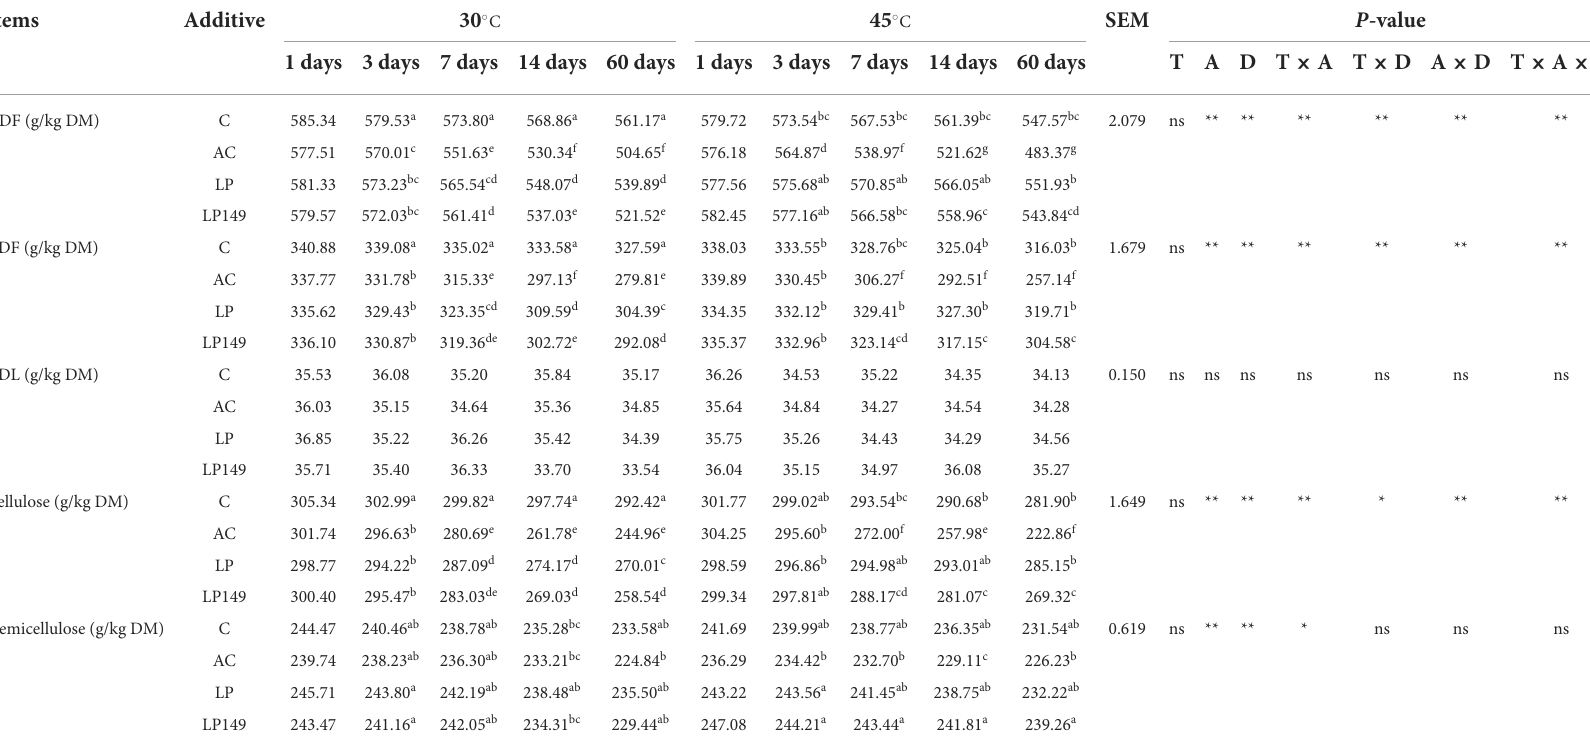
TABLE 2 Lignocellulose compositions of hybrid elephant grass silages treated with additives at different ensiling times and temperatures.